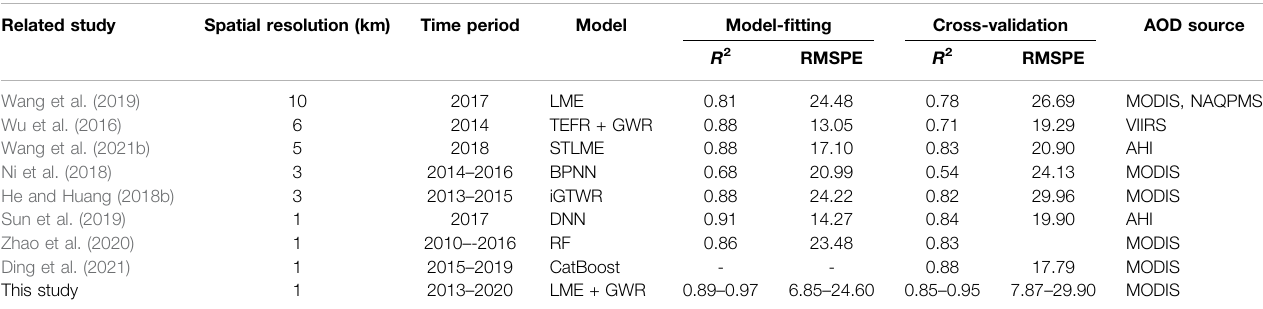
TABLE 4 | Performances of previous studies on PM 2.5 estimates in the Beijing – Tianjin – Hebei region. Related